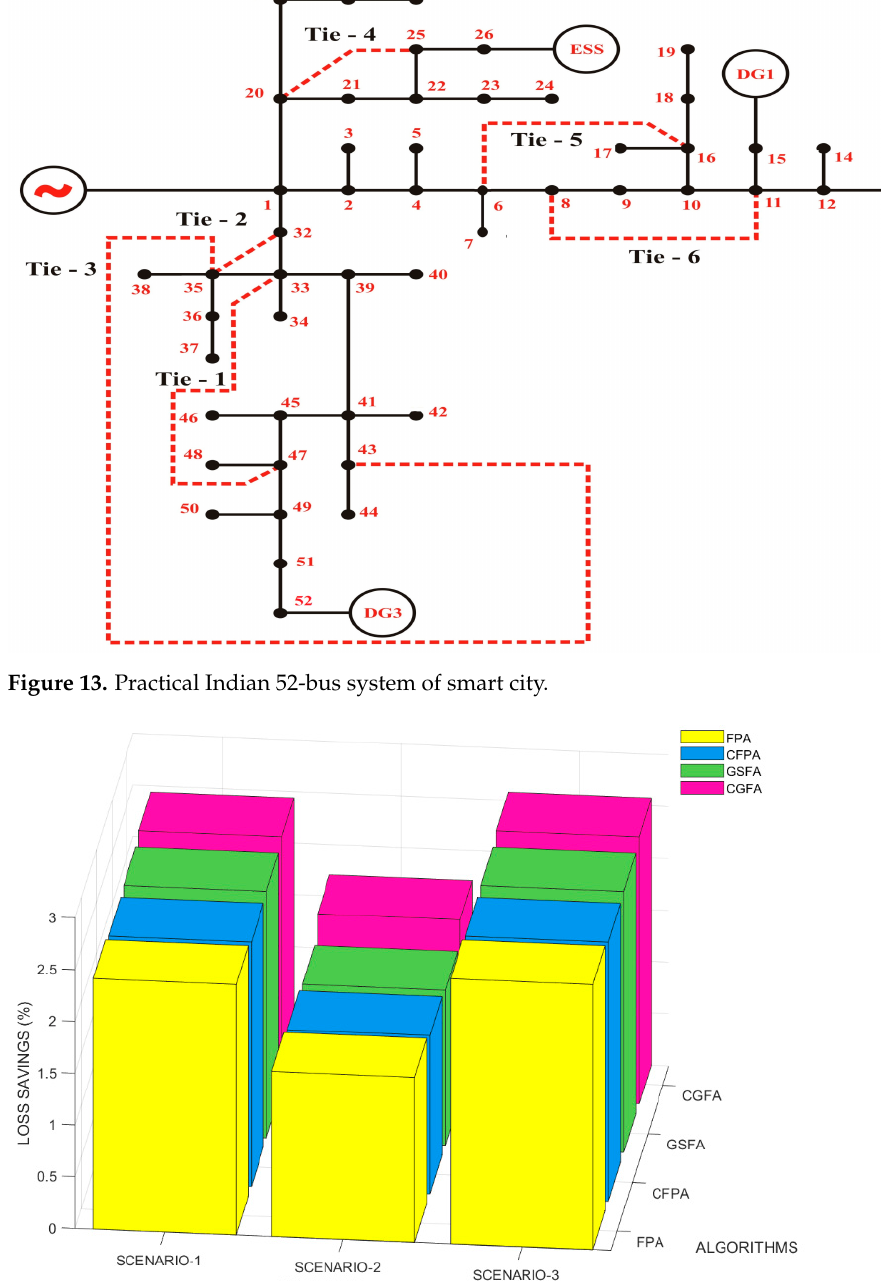
Table 7. Optimal tie-switch connections and power loss with the DNR in an SC network.